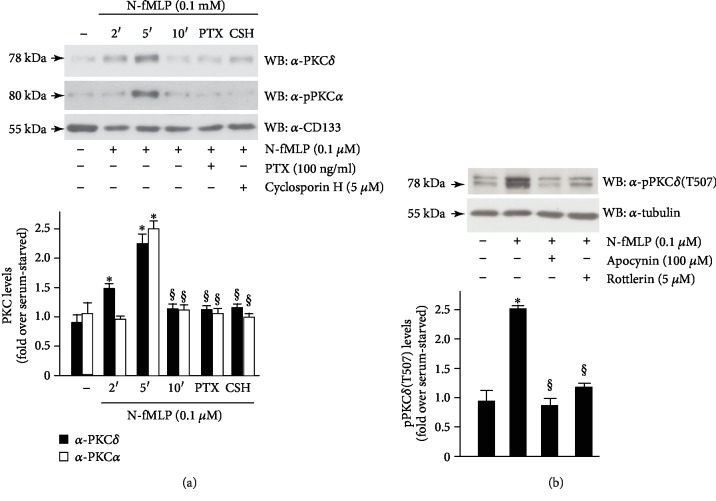
FPR1-mediated TrkA transactivation triggers PLCγ1/PKC pathway activation. SH-SY5Y cells were serum-deprived for 24 hours and (a) stimulated for 2, 5, or 10 minutes with N-fMLP or pretreated with PTX or cyclosporin H before the stimulation for 5 minutes with N-fMLP. (b) Cells were also preincubated with apocynin or rottlerin before N-fMLP stimulation. Fifty micrograms of membrane lysates was immunoblotted with (a) an anti-PKCδ (α-PKCδ) or anti-PKCα (α-PKCα) antibody or (b) with an anti-phosphoPKCδ (T507) (α-pPKCδ(T507)) antibody. An anti-CD133 (α-CD133) or an anti-tubulin (α-tubulin) antibody was used as a control for protein loading. ∗p < 0.05 compared to unstimulated cells. §p < 0.05 compared to N-fMLP-stimulated cells.